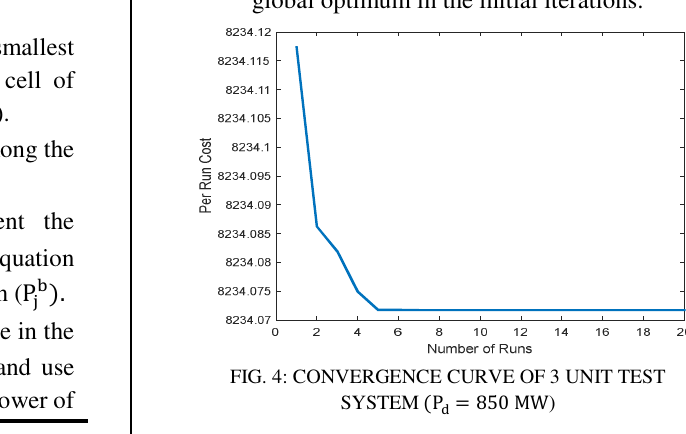
FIG. 4: CONVERGENCE CURVE OF 3 UNIT